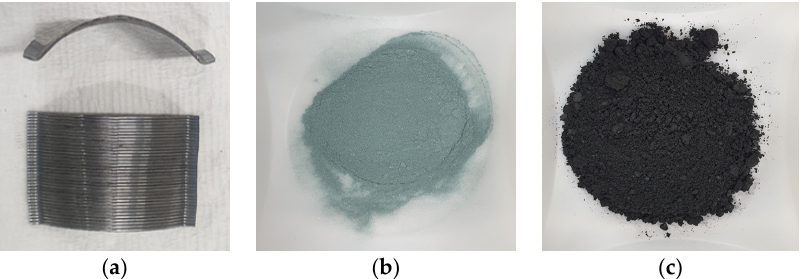
Figure 1. Used thermal conductive materials. ( a ) Arched-type steel fiber; ( b ) SiC; ( c ) Graphite